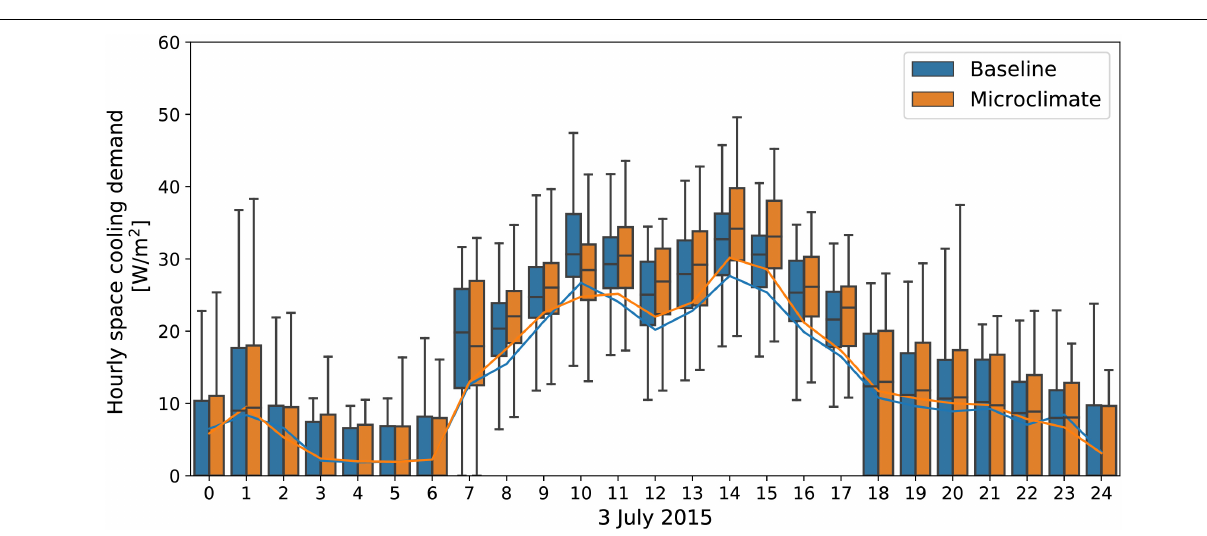
FIGURE 12 | Hourly space cooling demand in the district on the selected day for each of the climate cases. The boxplots at each hour show the distribution in the space cooling demand per conditioned floor area for all buildings in the area, whereas the lines show the entire district’s demand per square meter for each